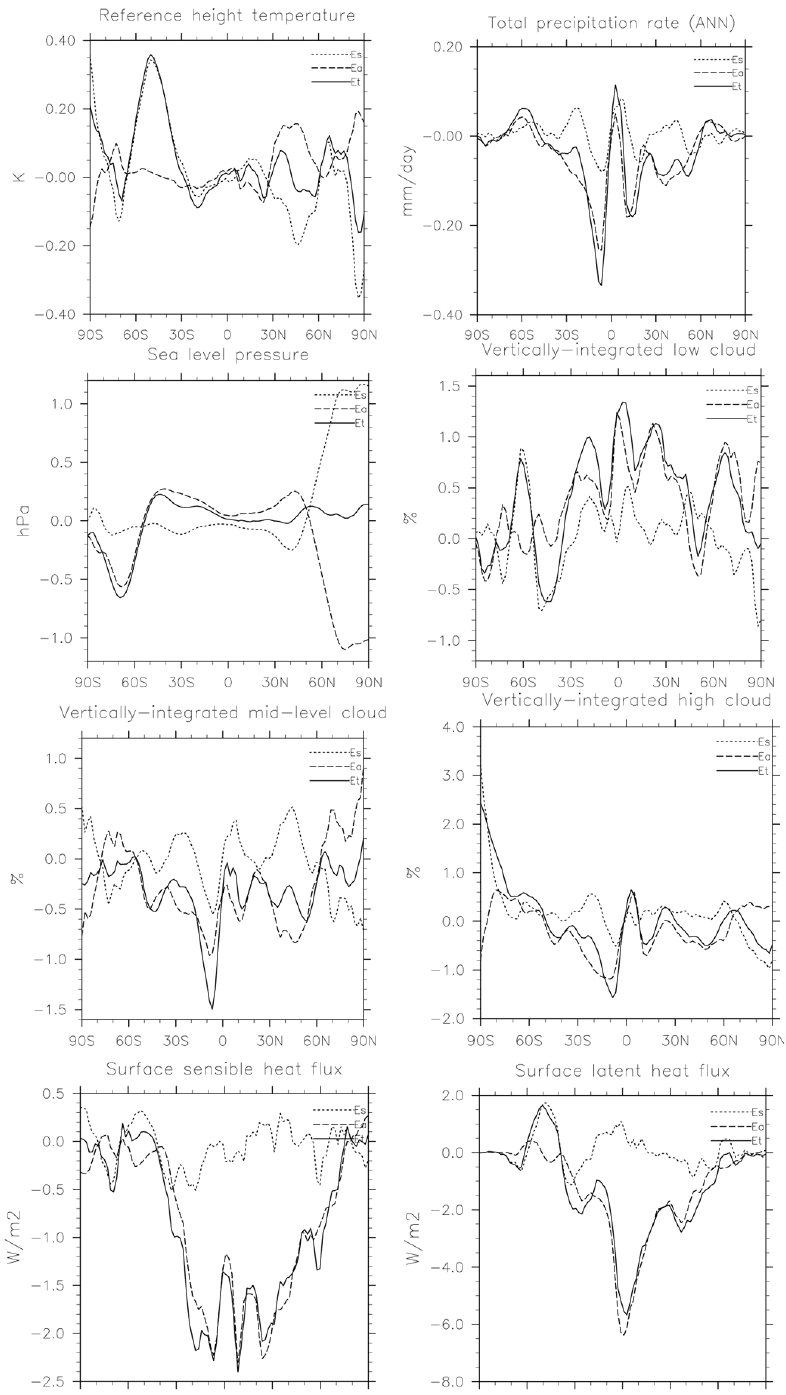
Fig. 8. Changes in zonal averages of surface air temperature; precipitation; SLP; low-, middle-, high-level cloud coverage; and sensible and latent heat flux. The unit of each variable is shown on the y